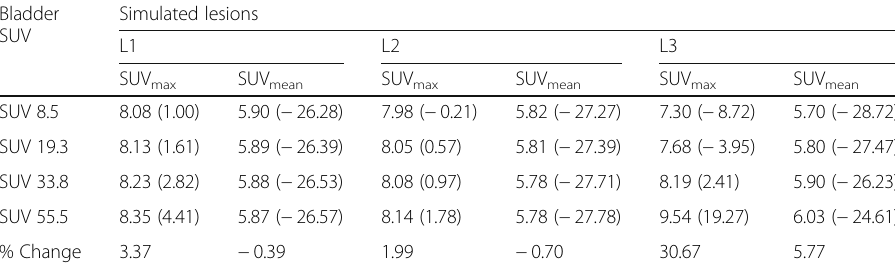
Table 1 The bias and relative change in lesion SUV max and SUV mean for all the simulated bladder SUVs and for lesion diameter 10 mm. These are estimated from the mean SUVs from all the noise realisations. (The % bias values are given in parentheses) Bladder SUV